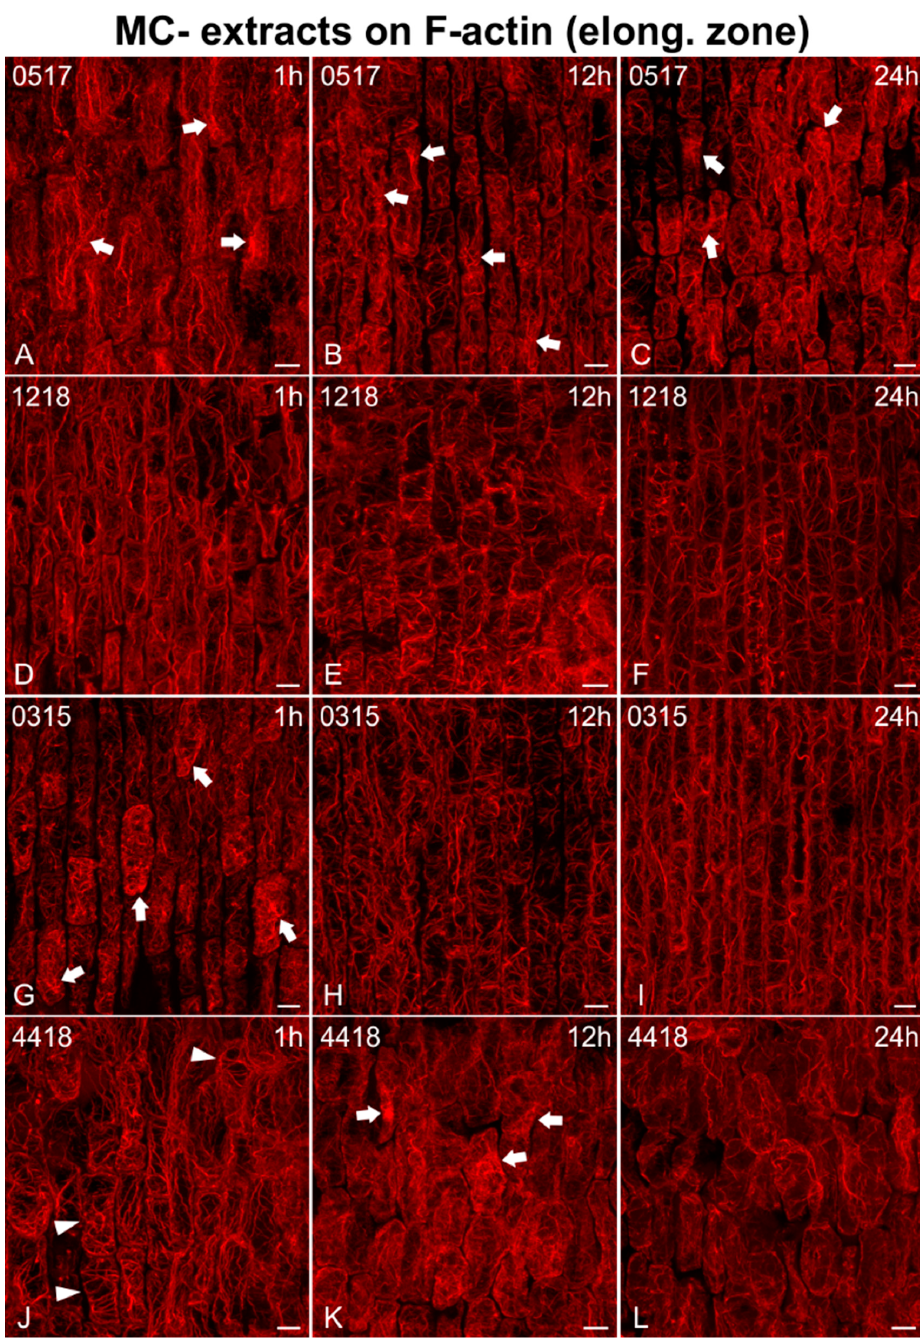
Figure 9. Maximum intensity projections of serial CLSM sections of Oryza sativa epidermal cells in the root elongation zone, stained for F-actin, after treatment with MC − extracts from various non-MC-producing strains: Phormidium sp. TAU-MAC 0517 ( A – C ), Scytonema sp. TAU-MAC 1218 ( D – F ), Nostoc oryzae TAU-MAC 0315 ( G – I ), and Lyngbya sp. TAU-MAC 4418 ( J – L ). Root tips in all images point towards the bottom of the page. Cells treated for 1 h either exhibited minor bundling of F-actin (arrows in A , G ) or retained a control-like state ( D , J ; cf. Figure 1B), with occasional minor disorientation e ff ects (arrowheads in J ). After 12 h, bundling e ff ects remained (arrows in B ) or progressed to the formation of actin aggregates (arrows in K ), while disorientation of actin cables was also visible ( E , H ). Actin aggregates (arrows in C ) and F-actin deterioration ( F , I , L ) were common alterations observed after 24 h of treatment. Scale bars: 10 µ